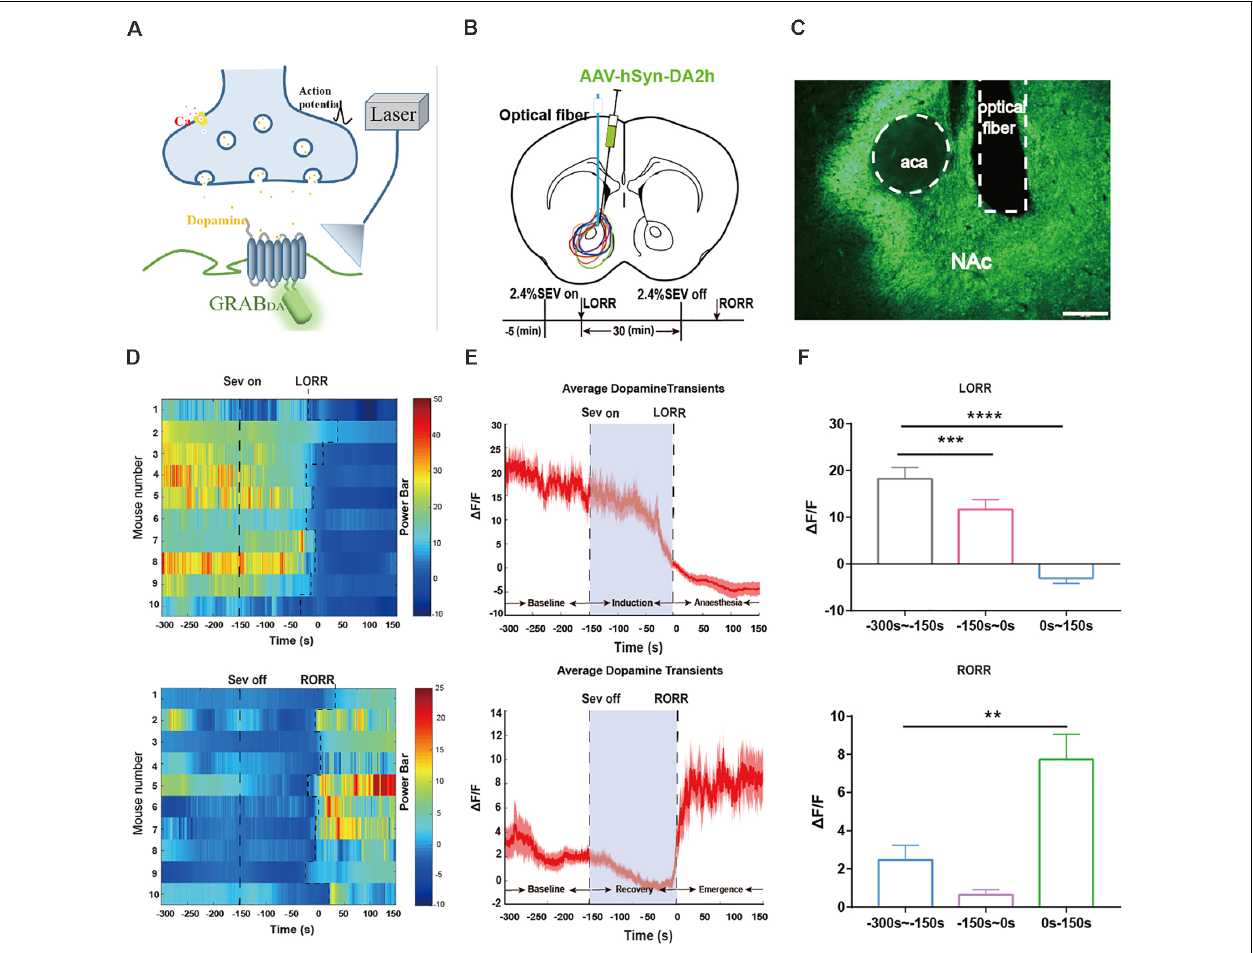
FIGURE 3 | Dynamics of extracellular dopamine in the nucleus accumbens (NAc) in response to sevoflurane anesthesia. (A) Schematic diagram depicting the fiber photometry recording of extracellular dopamine. (B) Expression of DA2 h in NAc from each cases are outlined. Timeline for dynamics of extracellular dopamine recording in sevoflurane anesthesia. (C) Expression of the DA2h virus in the NAc area (Scale bars: 200 µ m). (D) Heat map illustrating the changes in the DA fluorescence signals related to sevoflurane-induced LORR and RORR. (E) Average DA transmitters transients associated with LORR and RORR; mean (red trace) ± SEM (red shading). Note that the extracellular DA fluorescence signals gradually decreased with LORR and increased sharply after RORR. (F) ∆ F/F represents the deviation in the DA transmitter signal from the baseline, which is the averaged ∆ F/F between t = –300 s and –150 s. Data are presented as the mean ± SEM. ** p < 0.01; *** p < 0.001; **** p < 0.0001, n = 10, by paired t